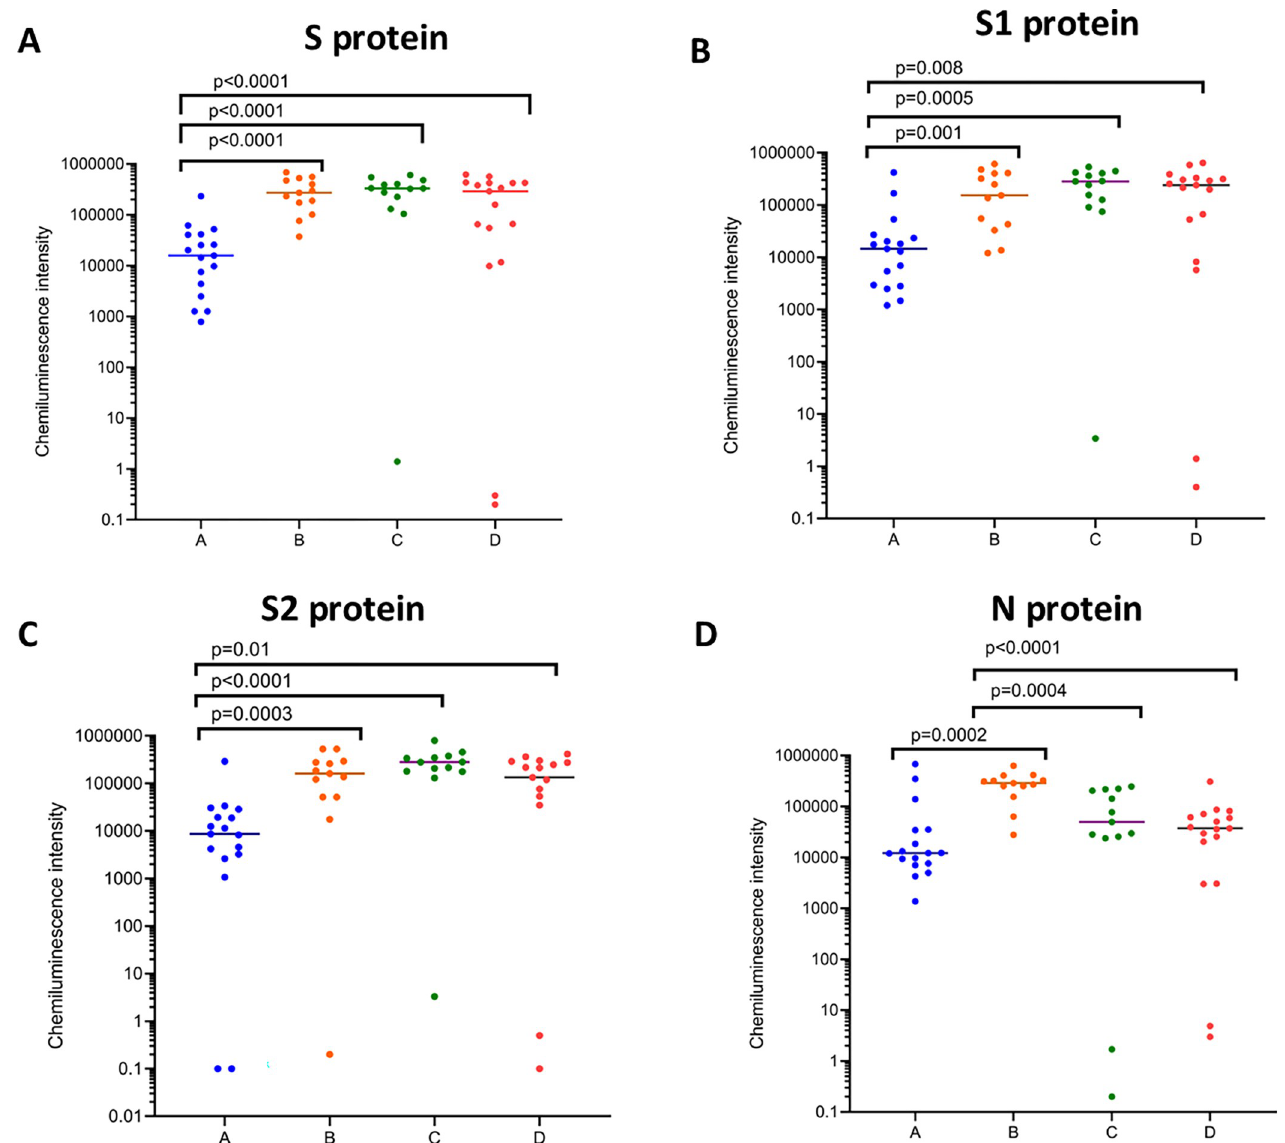
Fig 3. Antibodies to the different SARS-COV-2 proteins in Sinopharm/ BBIBP-CorV vaccinees who either received the BNT162b2 booster or were infected. IgG antibodies to SARS-CoV-2 spike (S), S1 subunit (S1), S2 subunit (S2) and nucleocapsid (N), were measured using the Peggy Sue platform, in Sinopharm vaccinees at 7 months post second dose, who remained uninfected and un-boosted (cohort A: n = 21), or those who had previous infection and who did not obtain the booster (cohort B: n = 17), or those who were not infected but who received a BNT162b2 booster (cohort C: n = 30), or those who did not receive the booster, but were infected with omicron (cohort D: n = 29). The Mann-Whitney test was used to compare the IgG levels between different cohorts for the different proteins. All tests were